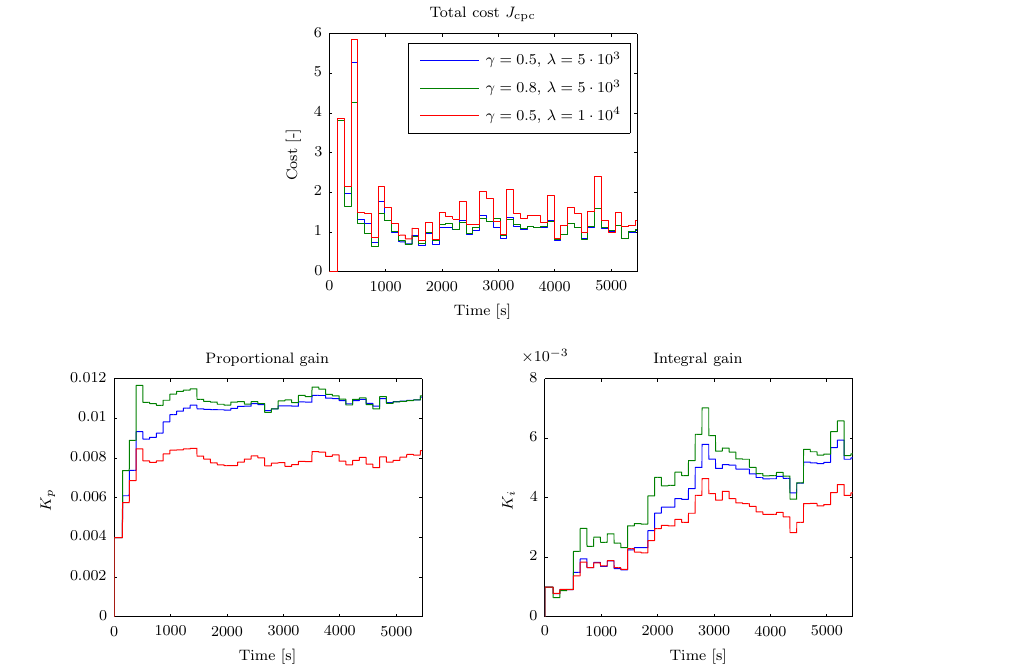
Figure 14. Reference step tuning using IFT of CPC at a wind speed of 14ms − 1 with 4% turbulence intensity. The results show three different cases where the step size γ and the input weighting λ in the cost function are varied.